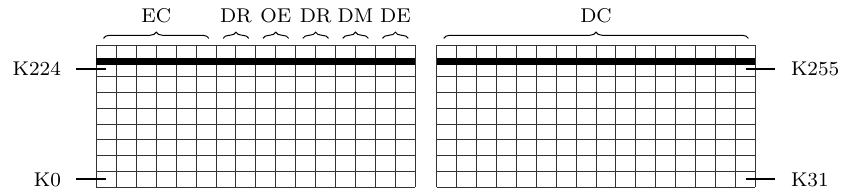
Figure 13: Mapping of the individual AES key bits (K) in the BBRAM. The bit number increases from left to right and bottom to top. Additionally, other security-relevant data is saved at the top row: EC = error check, DR = DPA countermeasure reserved bits, OE = key obfuscation enable, DM = DPA countermeasure mode, DE = DPA countermeasure enable, DC = DPA countermeasure counter (8 bit,